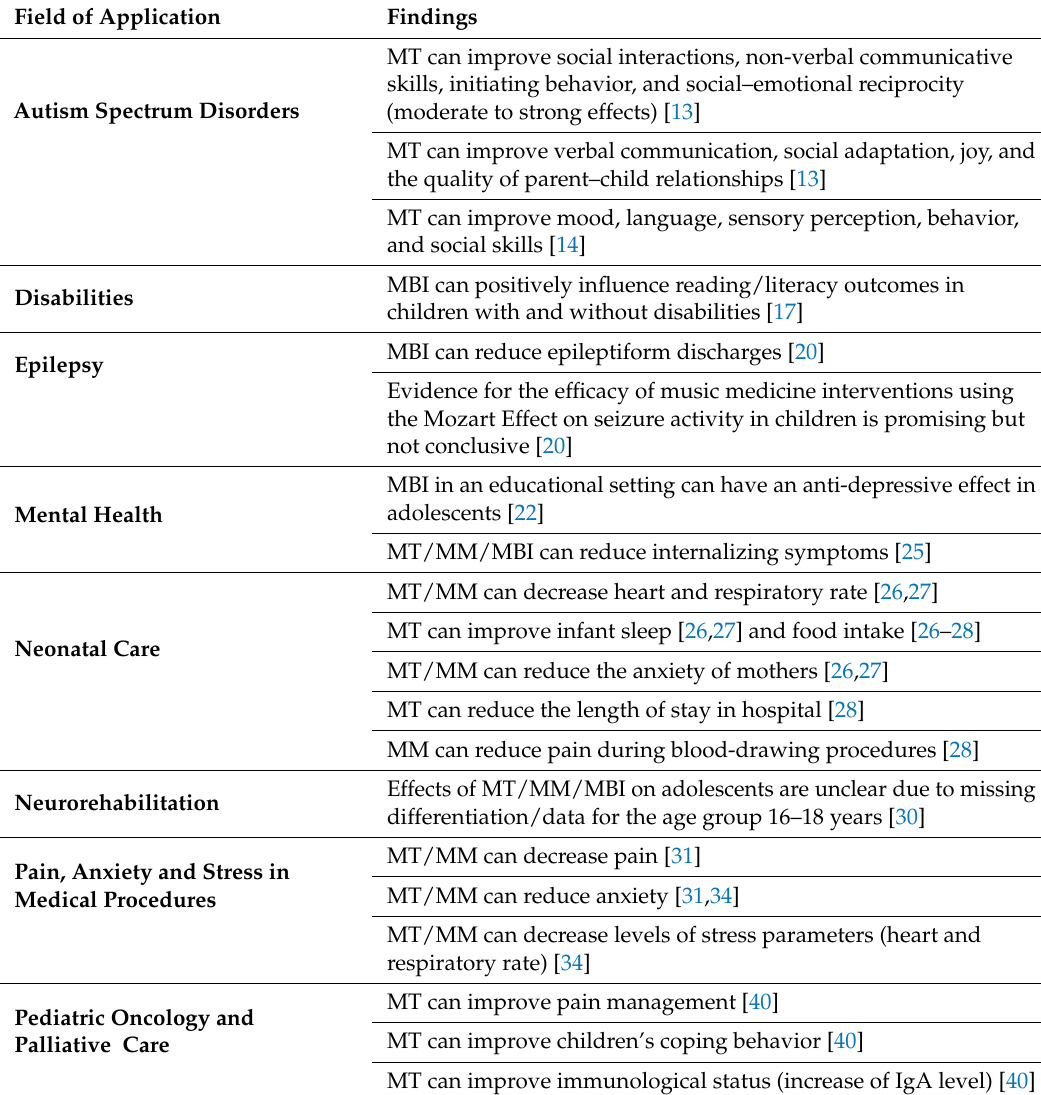
Table 2. Summary of findings regarding evidence for the effectiveness of music therapy (MT), music medicine (MM) and other music-based interventions (MBI) in selected fields of applications relevant to pediatric health